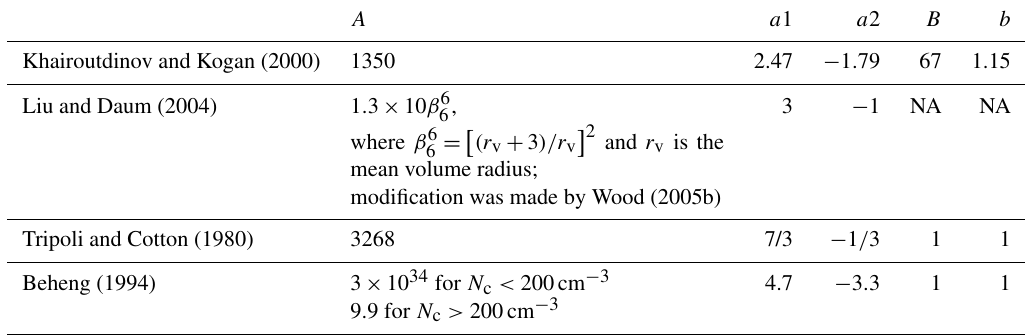
Table 1. The parameters of autoconversion and accretion formulations for four parameterizations. NA – not available. A a 1 a 2 B b